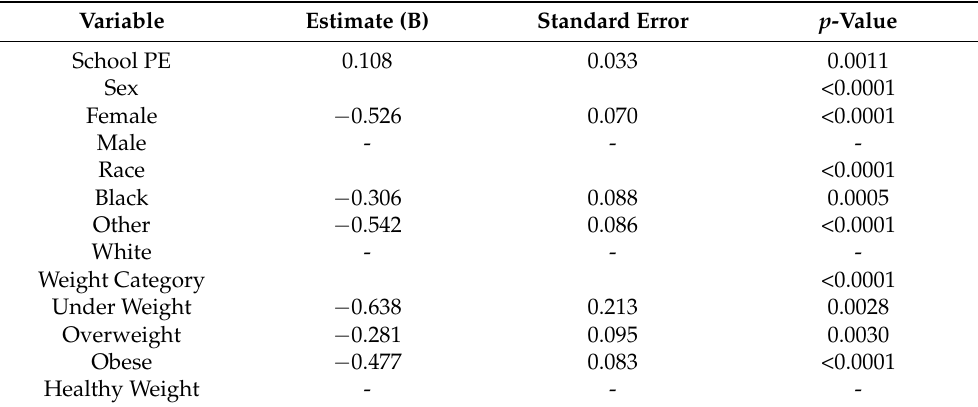
Table 4. Multiple regression model between school PE, sex, ethnicity, weight category, and self- reported days per week (0–7) of 60 min of